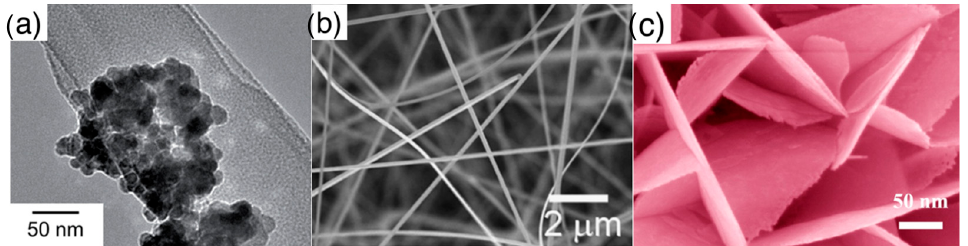
Figure 3. Elementary units (crystallites) composing the nanostructured metal oxide layers: ( a ) nanoparticles, ( b ) nanorods, ( c ) nanosheets. ( a ) is reprinted with permission of Royal Society of Chemistry (RSC), from [16], permission conveyed through Copyright Clearance Center, Inc.; ( b ) is reprinted from [48], Copyright (2008), with permission from Elsevier; ( c ) is reprinted with permission from [49], Copyright (2014) American Chemical Society.